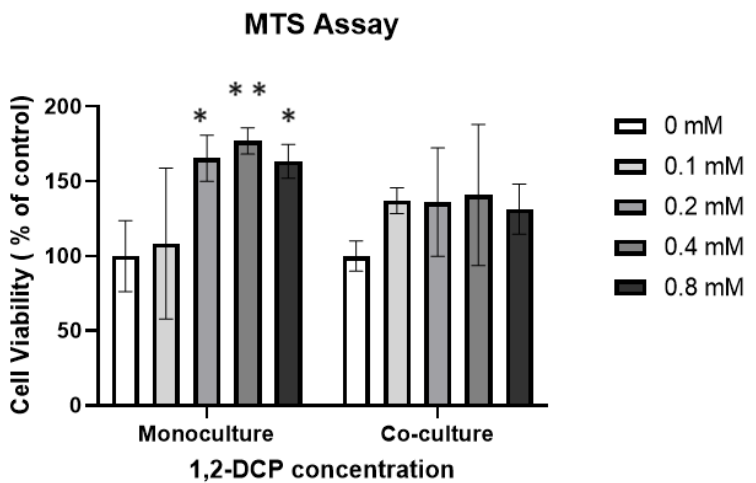
Figure 1. Results of the MTS assay on the effects of 1,2-DCP on cell viability of monocultured MMNK-1 cholangiocytes and MMNK-1 cholangiocytes co-cultured with THP-1 macrophages. Monocultured MMNK-1 cells or co-cultures of MMNK-1 cells/THP-1 macrophages were exposed to 1,2-DCP at 0, 0.1, 0.2, 0.4, and 0.8 mM for 24 h. Percentages are in relation to 0 mM 1,2-DCP group. Data are mean ± SD, n = 3. * p < 0.05, ** p < 0.01 compared with the control group (0 mM), by two-way ANOVA followed by Dunnett’s multiple comparison test.